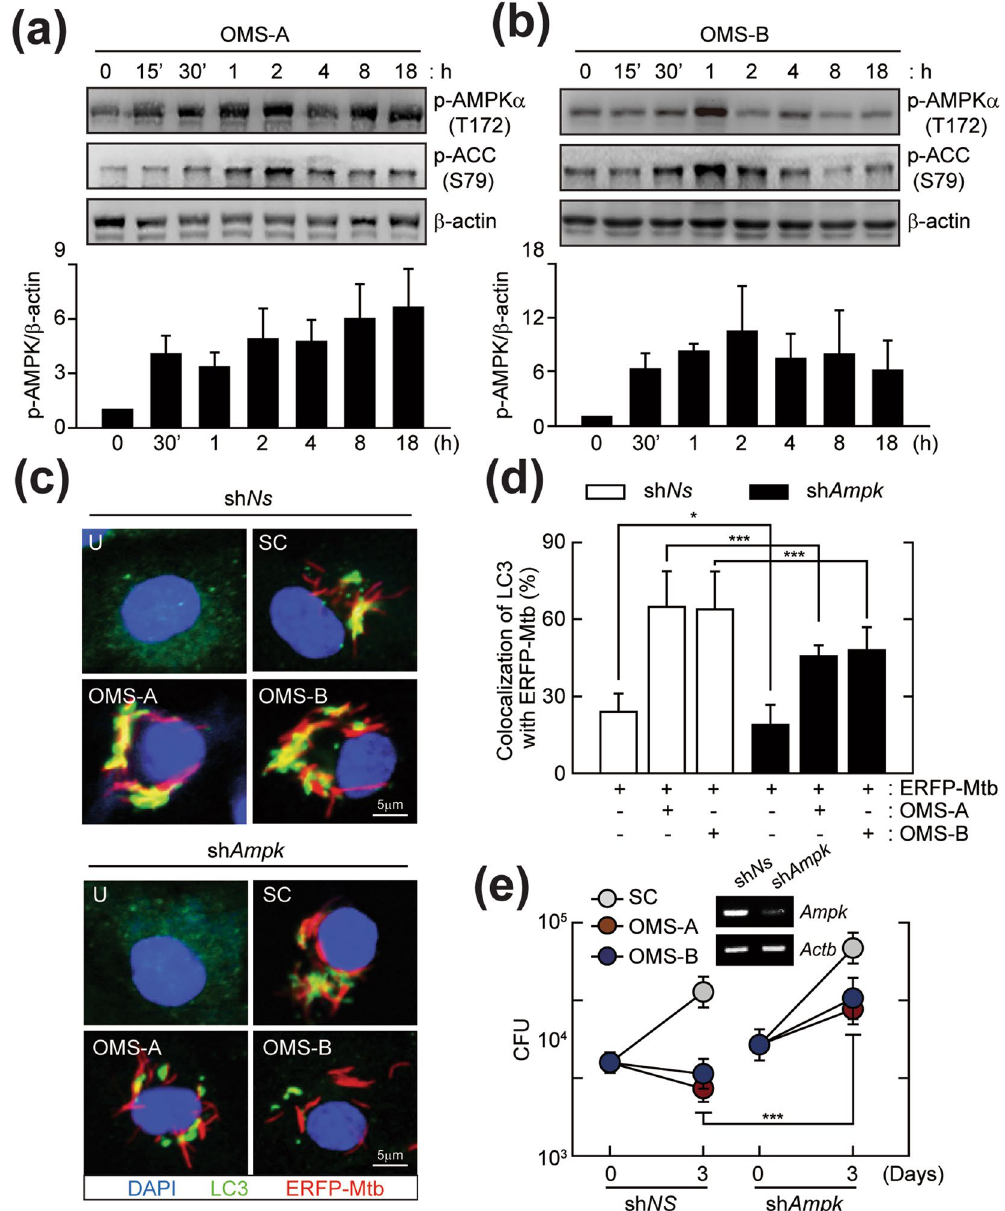
Figure 4. AMPK activation is required for OMS-induced phagosomal maturation and antimicrobial responses. ( a and b ) BMDMs were treated with OMS-A (10 μ M; for a ) or OMS-B (10 μ M; for b ) for indicated times (0–18 h). The cell lysates were subjected to immunoblot analysis of p-AMPK α , p-ACC, and Actin. The entire blots are shown in Supplementary Fig. 7. The densitometric values for p-AMPK α were normalized to Actin ( bottom ). ( c and d ) BMDMs were transduced with non-specific shRNA (sh NS ) or Ampk -specific shRNA (sh Ampk )-expressing lentivirus for 48 h and then infected with ERFP-Mtb (moi = 10) for 4 h, followed by treatment with OMS-A or OMS-B for 24 h. ( c and d ) Mtb-ERFP (red), Alexa 488-conjugated-LC3 (green), and DAPI (blue) were detected by confocal analysis. Scale bar, 5 µ m. ( c ) Representative confocal microscopic images from three independent samples are shown. ( d ) Quantitative analysis of cells showing the colocalization between LC3 and Mtb-ERFP. For each experiment, at least 100 cells were scored from 6 random fields. ( e ) After 3 days of infection, intracellular bacterial loads were determined by CFU assay. (inset) RT-PCR analysis of Ampk mRNA expression of transduction efficiency. Data shown are from one representative of at least three independent experiments (means ± SD of triplicates [ a , b bottom ; d ] samples]). * p < 0.05, *** p < 0.001, compared with sh NS . U, uninfected/untreated; SC, solvent